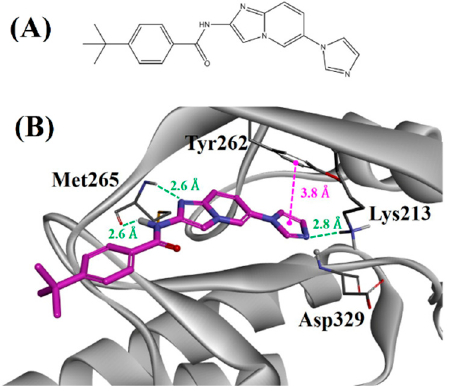
Figure 4. ( A ) Two-dimensional (2D) structure of compound 1 . ( B ) Binding mode of compound 1 against IRAK4. The green and magenta lines represent hydrogen bond and hydrophobic interactions, respectively.